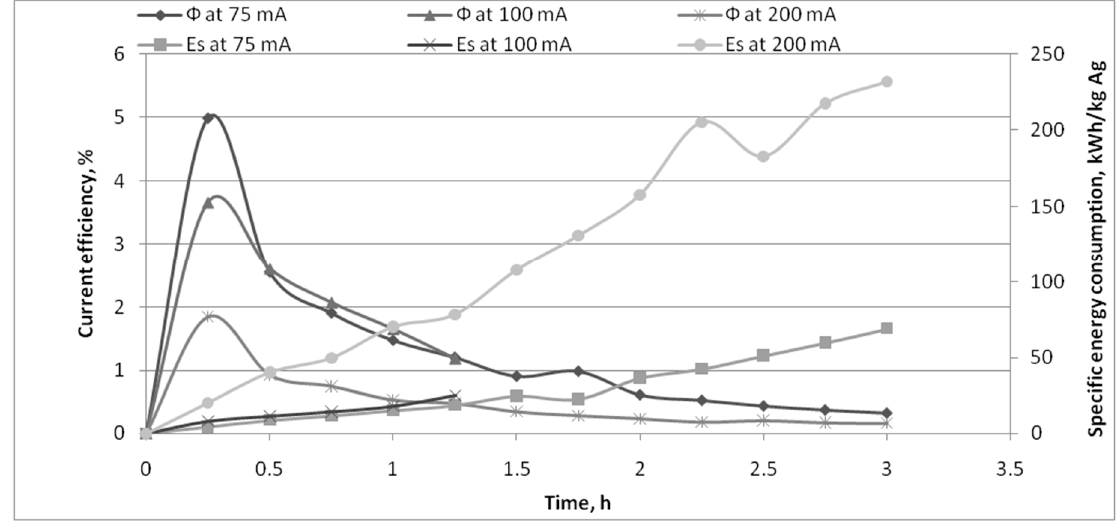
Figure 8. Current efficiency and specific energy consumption at different current intensity vs. time for Ag.